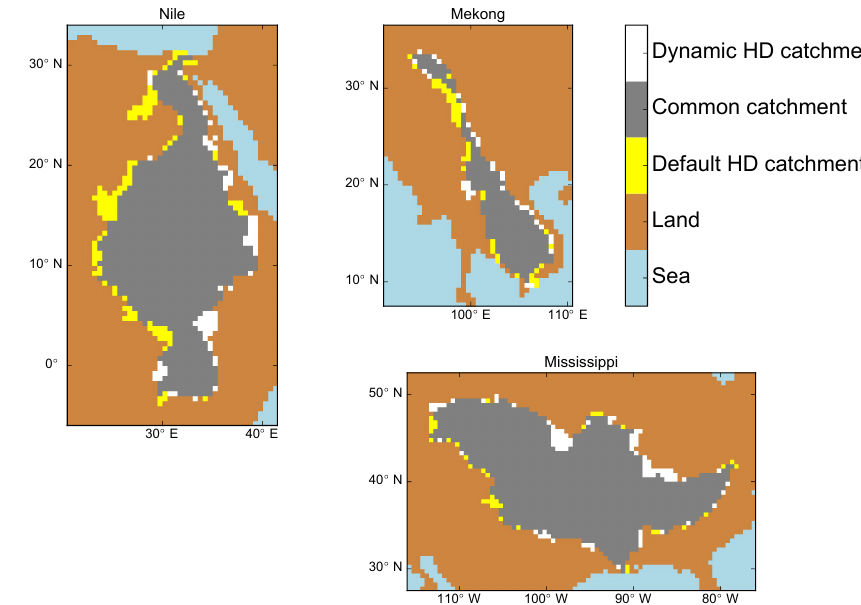
◦ catchments for the present day (“default HD”) to those of the 10min directions Figure 4. Comparison of the manually corrected 0 . 5 generated from a corrected 10min present-day orography (“dynamic HD”) for the Nile, Mekong and Mississippi.